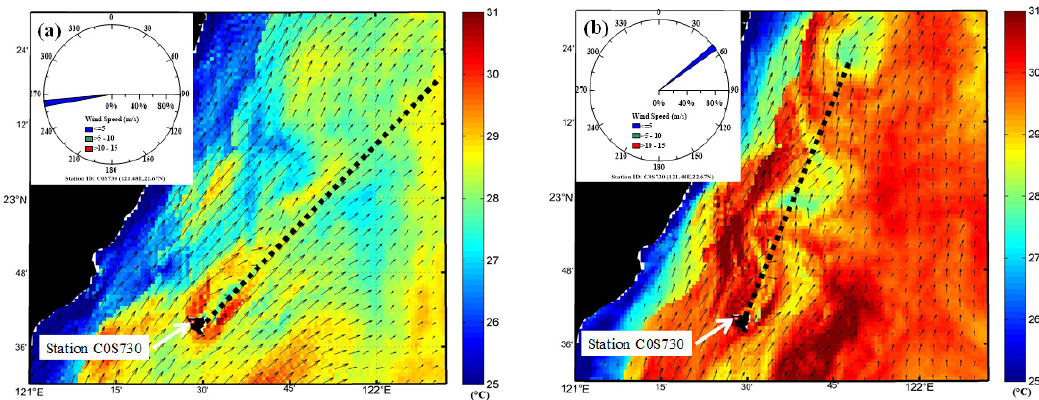
( b ) the NE wind condition.